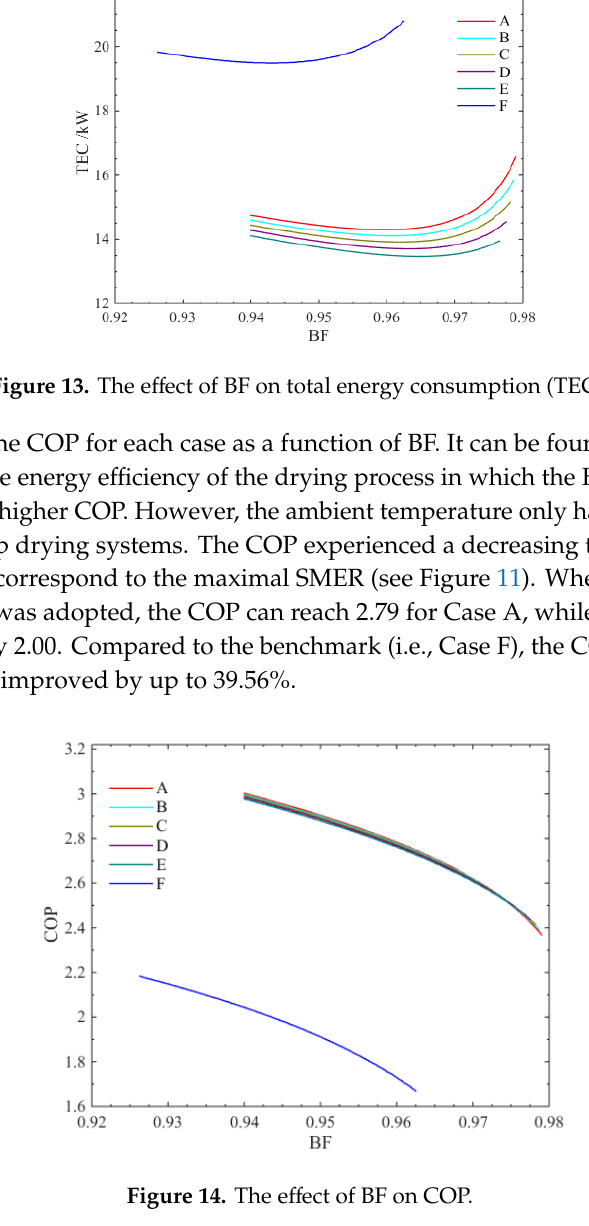
Figure 14. The effect of BF on COP. Figure 14. The e ff ect of BF on